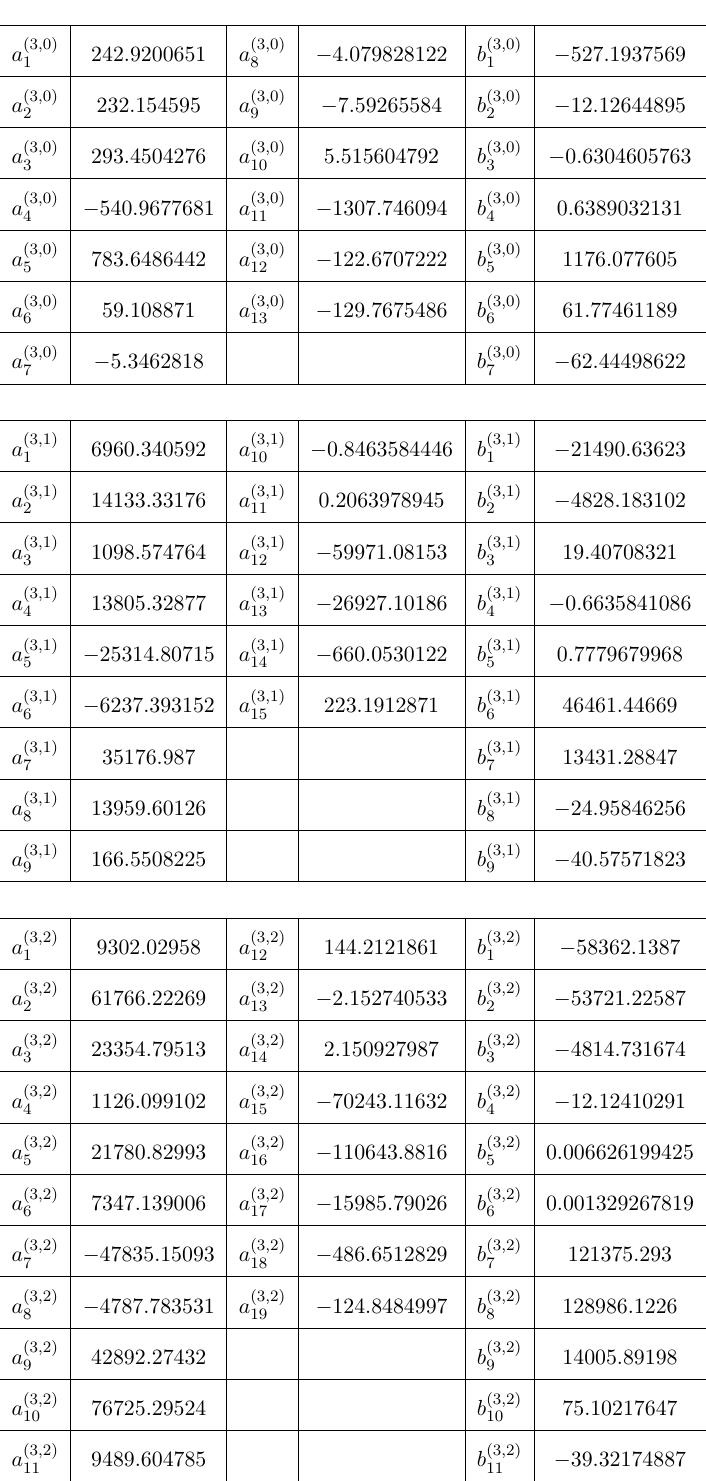
Table 3 . Coe(cid:14)cients of the (cid:12)t functions F (3 ;j ) for j = 0 ; 1 ; 2.